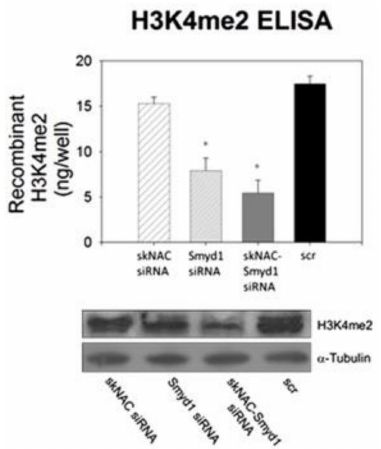
Figure 4. Regulation of histone modification patterns by skNAC and SMYD1 measured using an ELISA and a Western blot. A decrease in H3K4me2 is observed when cells had been transfected with SMYD1 siRNA and to a lesser extent with skNAC-specific siRNA. Adopted with permission from Elsevier Ref. [93]. Data are expressed as mean ± SD ( n = 3). * p <